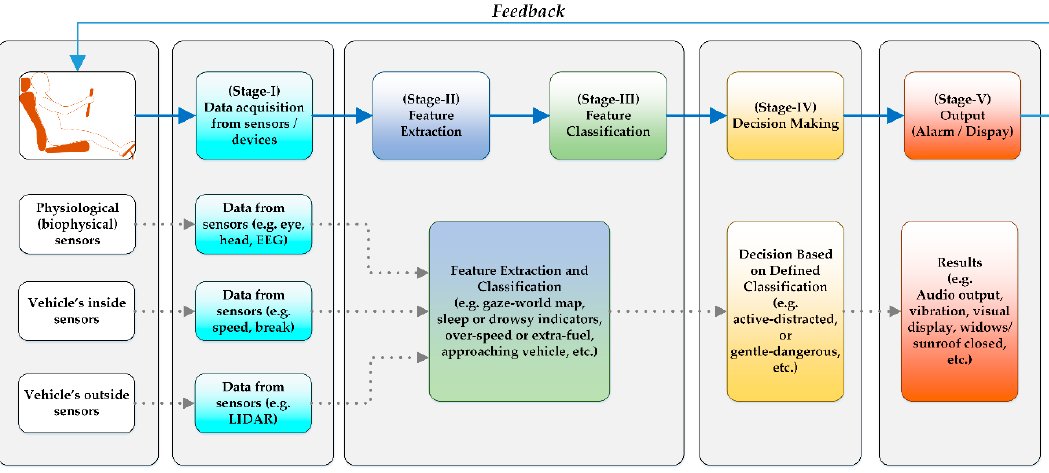
Figure 3. Layout of a typical DMAS.